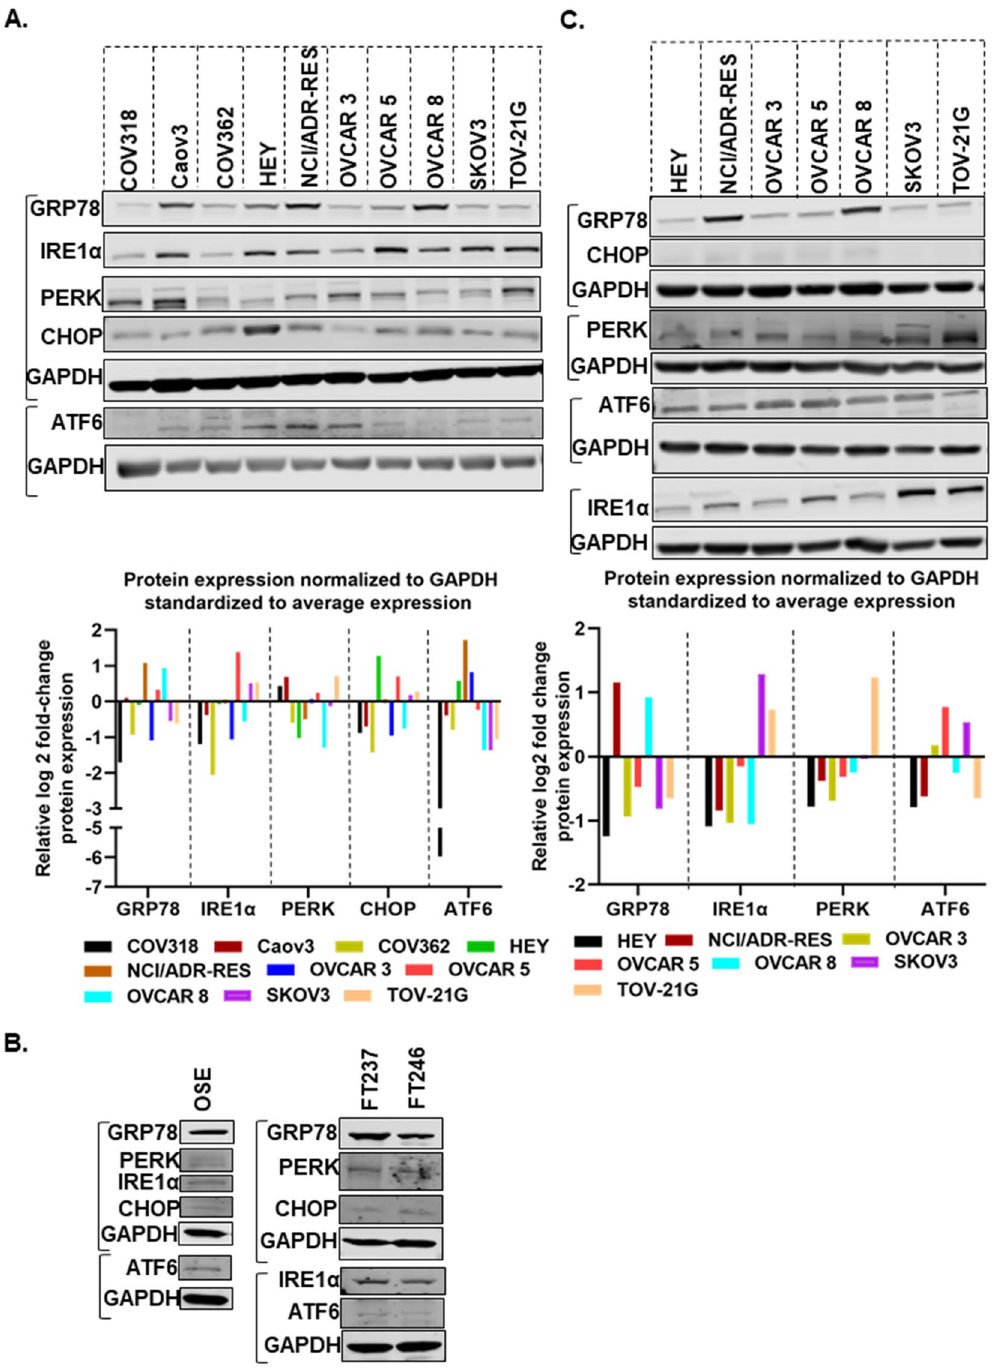
Figure 1. ER-stress associated proteins are highly expressed in ovarian cancer cells and xenograft models. ( A ) Protein expression levels of GRP78, ATF6, PERK, IRE1 α , and CHOP in a panel of ovarian cancer cell lines. ( B ) Expression of ER-associated proteins in OSE (normal ovarian surface epithelial) and FT (normal fallopian tube) cells. ( C ) Expression levels of GRP78, ATF6, PERK, IRE1 α , and CHOP proteins in a panel of ovarian cancer xenograft models. Relative band intensity of the protein of interest normalized to GAPDH using Image Studio software v5.2. Log 2 fold change of each protein expression standardized to the average expression in all cells was calculated and the relative log 2 fold change of protein expression is presented (GraphPad Prism 8.1.0). Each group of blots represents data obtained from a single gel and experiment. Different areas of the PVDF membrane are separated by white